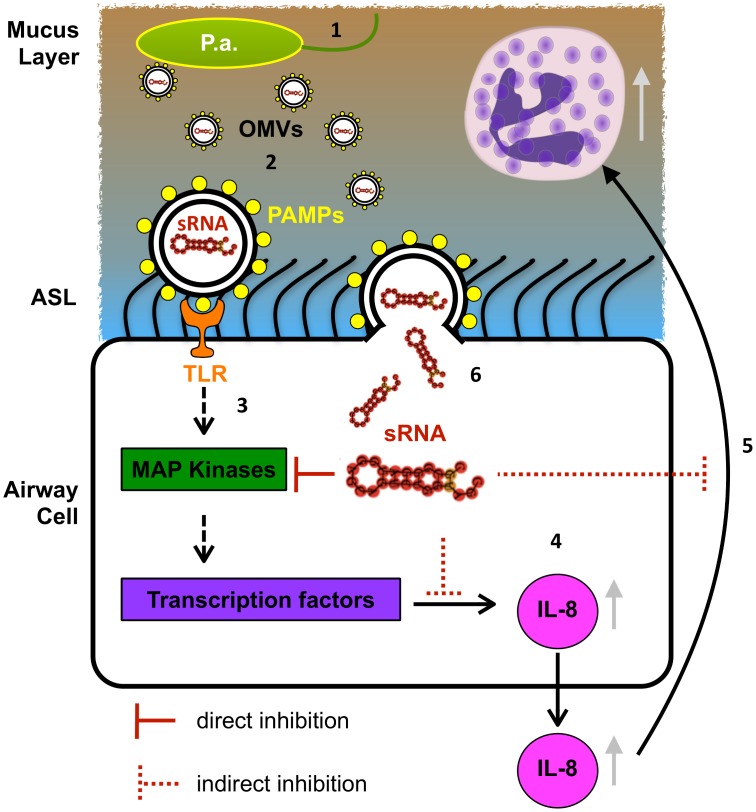
Model of OMV sRNA mechanism of action.(1) P. aeruginosa (P.a.) resides in the airway mucus layer and produces OMVs. (2) OMVs traverse the mucus layer and reach the airway epithelial cells. (3) Pathogen-associated molecular patterns (PAMPs) on the outside of OMVs induce the host innate immune response by activating the Toll-like receptor and MAP-kinase (TLR/MAPK) signaling pathway. (4) Activation of transcription factors leads to up-regulation of IL-8 mRNA and IL-8 protein secretion. (5) IL-8 is a potent chemoattractant for neutrophils, which infiltrate the lungs and phagocytose P. aeruginosa. (6) OMVs also fuse with and deliver sRNA52320 into cells, which targets the mRNA of MAP-kinases upstream of IL-8, leading to reduced host IL-8 secretion and neutrophil recruitment. sRNA52320-mediated attenuation of the innate immune response to LPS is a novel mechanism of pathogen-host interaction that may facilitate chronic infection by P. aeruginosa.